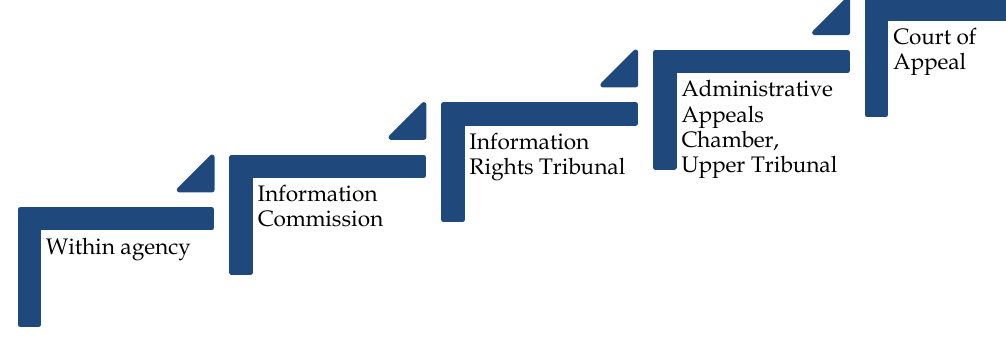
Figure 8: Levels of RTI Appeals in the United